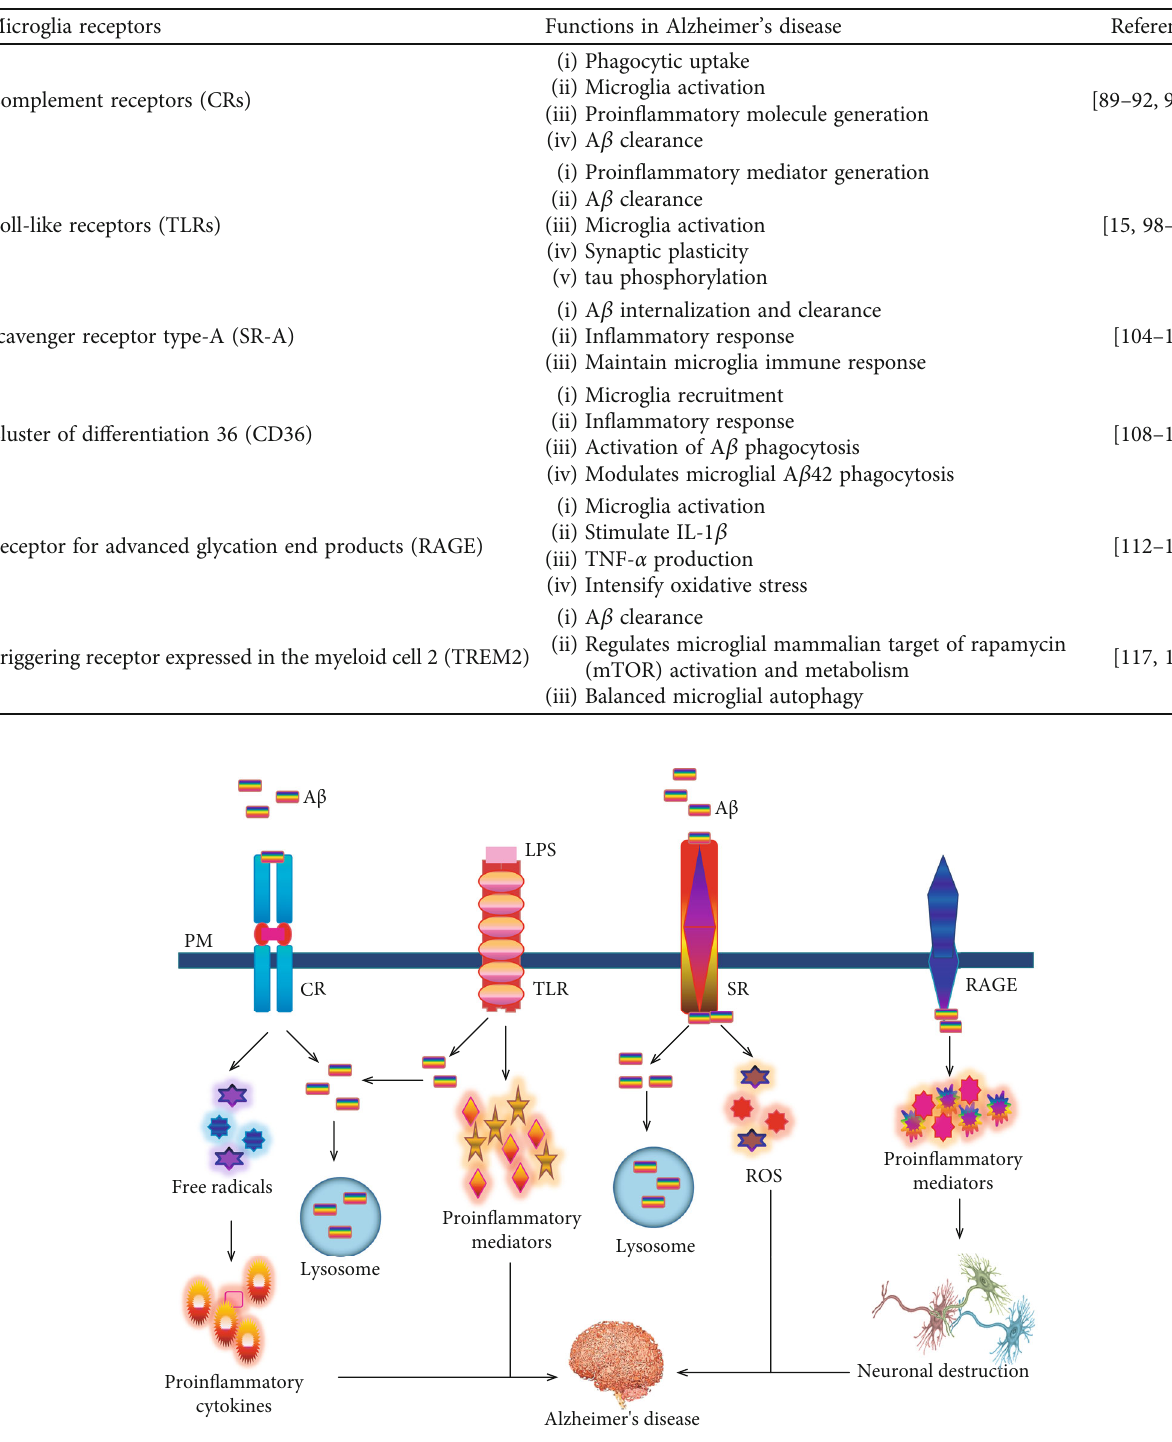
Table 1: Outline of microglia receptors and their function in Alzheimer ’ s disease.